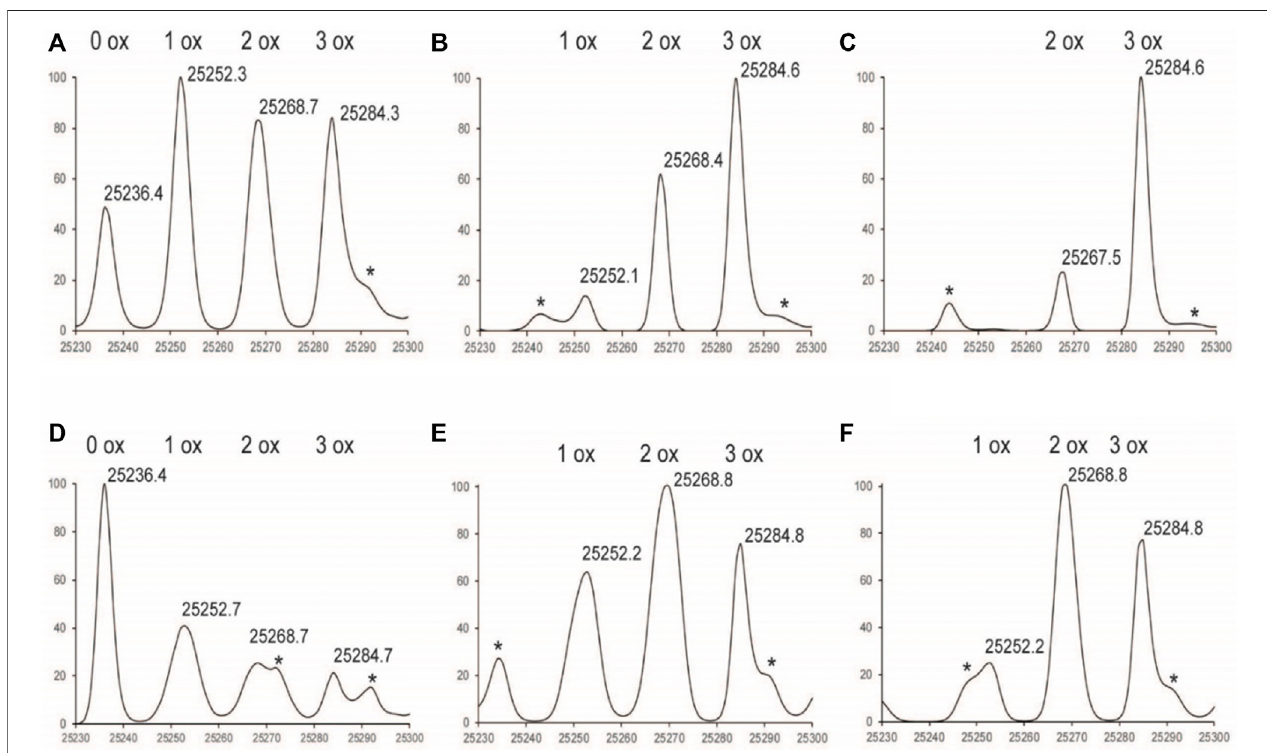
FIGURE 1 | Deconvoluted LC-MS Spectrum of Fc subunit zoomed in to G0F (A) 1% Nox 1hr (B) 1% Nox 3hr (C) 1 % Nox 6hr (D) 1% PAox 1hr (E) 1% PAox 3hr (F) 1% PAox 6hr *Denotes adduct peaks that do not correspond to actual oxidized antibody peaks.